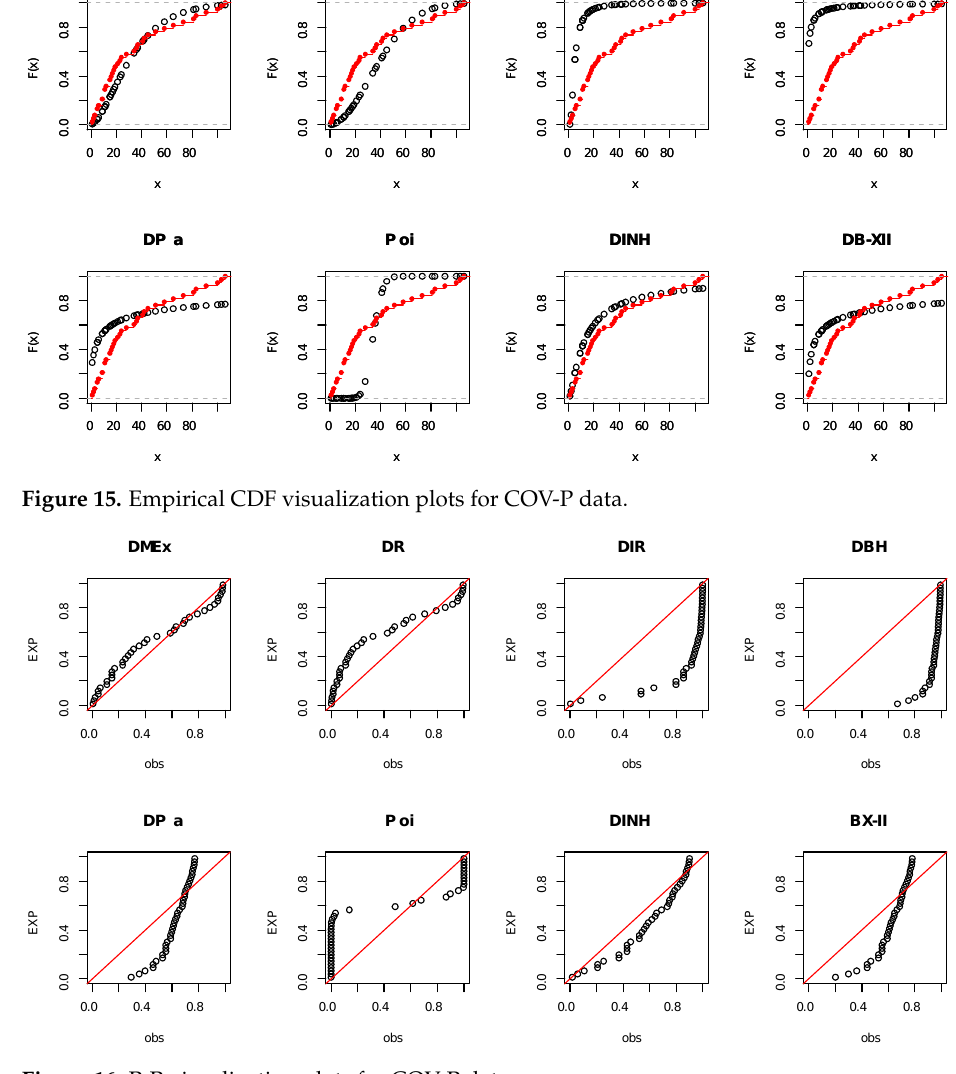
Table 17. The EDS for COV-P Table 16 . Di⁄erent estimators for COV-P data.